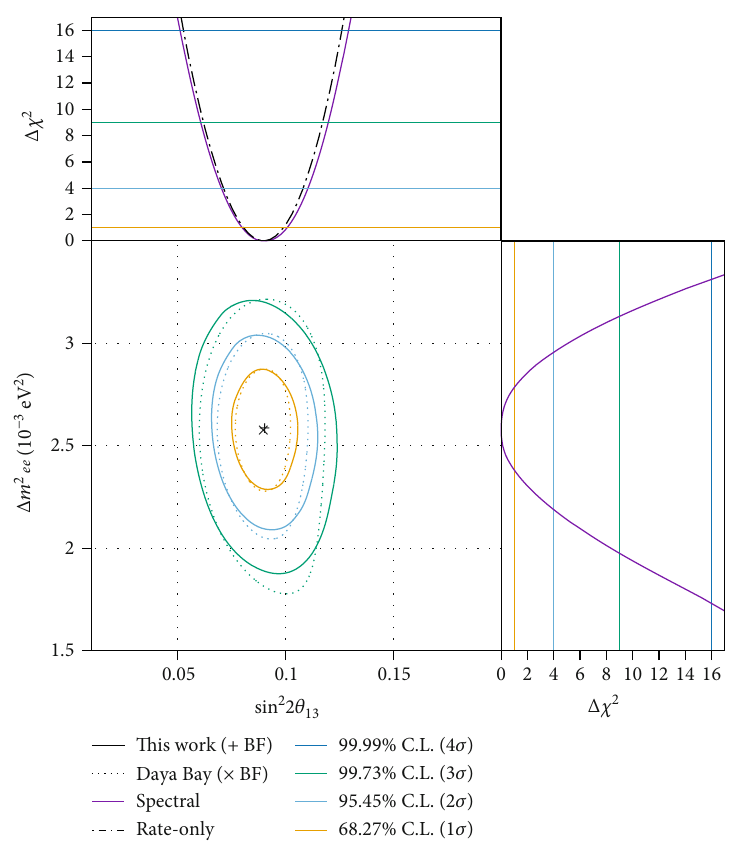
, Δ m 2 Þ space at a 68.27%, 95.45%, and 99.73% C.L. from our Daya Bay analysis. The best fi t is Figure 7: Allowed regions in the ð sin 2 2 θ 13 ee marked by a “ + ” in the central plot, where the published Daya Bay contours [15] are also included. The marginalized Δχ 2 over the oscillation parameters are also shown in the upper and right plots, including the rate-only result (dot-dashed line) for the mixing angle, and the 99.99% C.L. line (solid dark